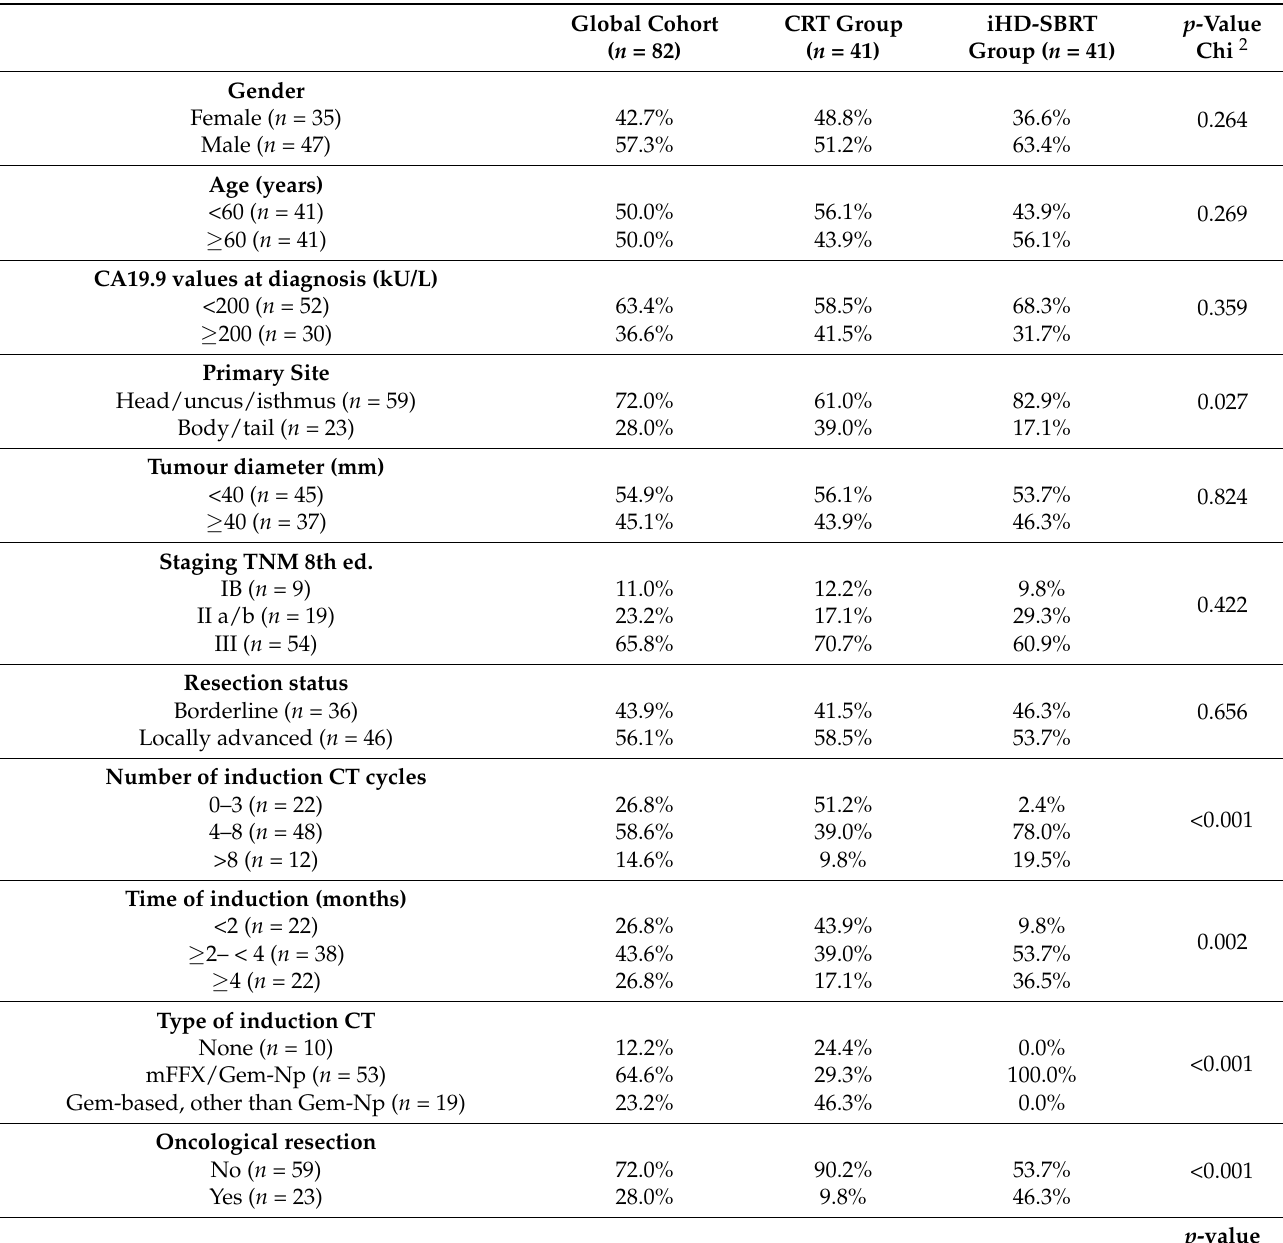
Table 1. Baseline characteristics of the iHD-SBRT and the conventional CRT